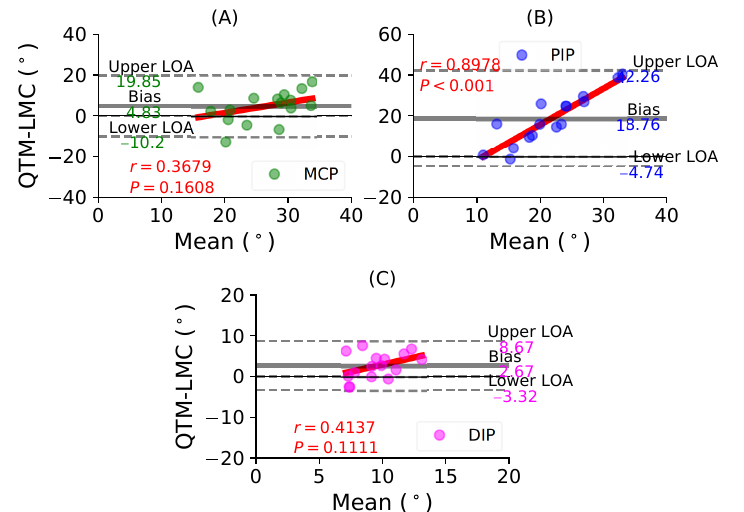
Figure 9. A BA plot of ring finger flexion. ( A ) MCP joint comparison, ( B ) PIP joint and ( C ) DIP